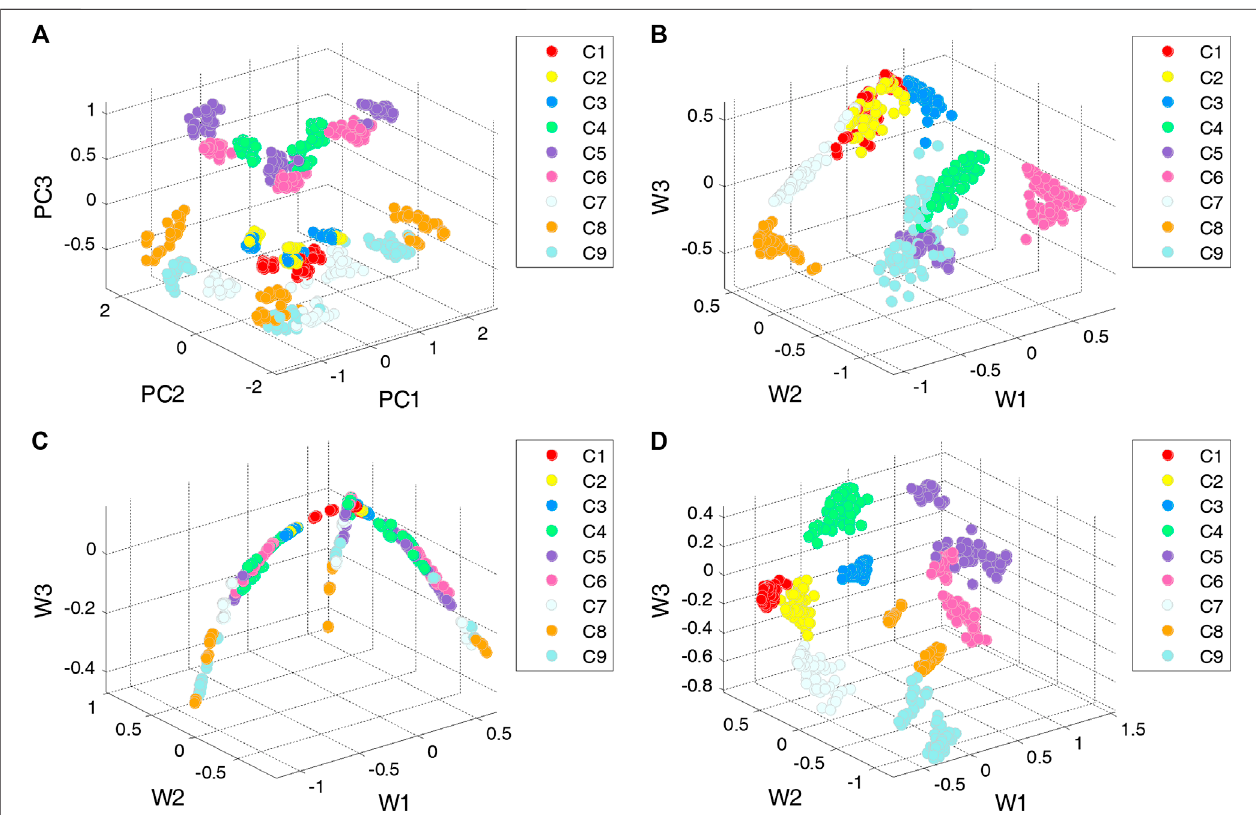
FIGURE 17 | Comparison of feature extraction effects: (A) PCA; (B) ANN; (C) RBM; (D) DBN.